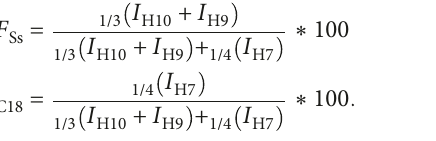
Ss 301 H NMR spectrum (400MHz, 70